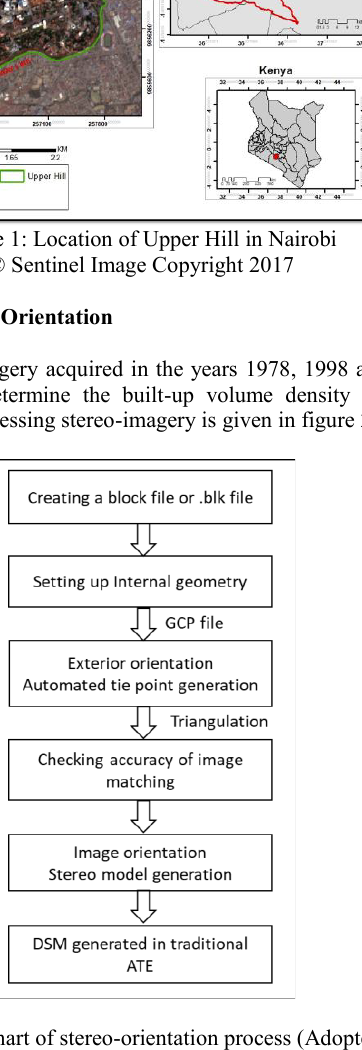
Figure 2: Flow chart of stereo-orientation process (Adopted from: